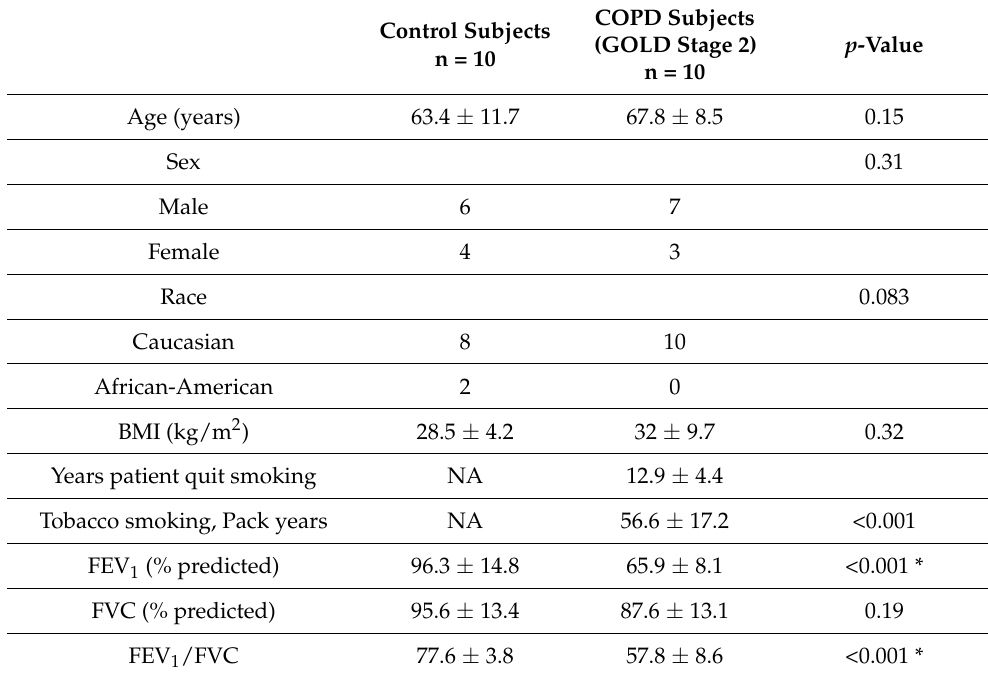
Table 1. Clinical parameters of never-smoking healthy subjects and ex-smokers with stable COPD in BALF